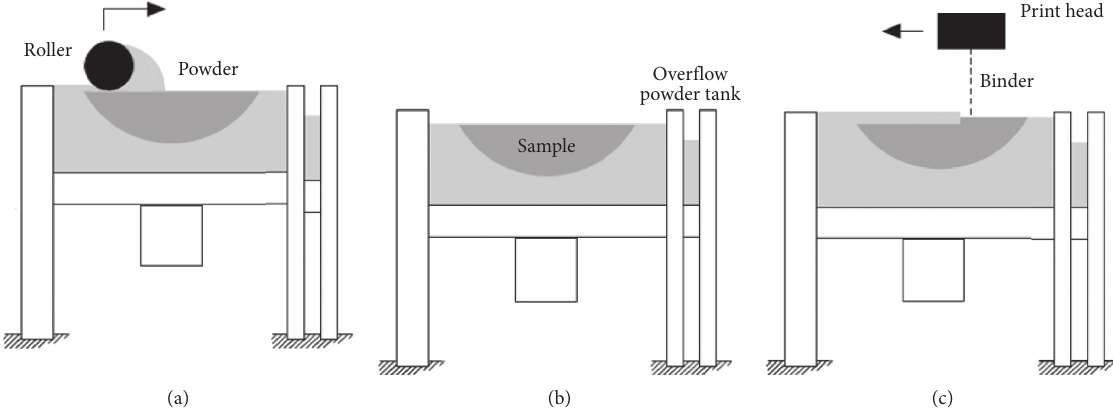
Figure 2: Printing process of 3D printer. (a) Laying powder. (b) Lowering the build bed. (c) Spray